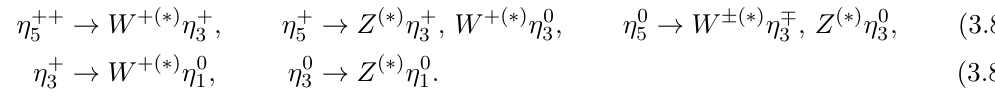
for m 1 (cid:29) m 5 > m 3 = 600 GeV 3